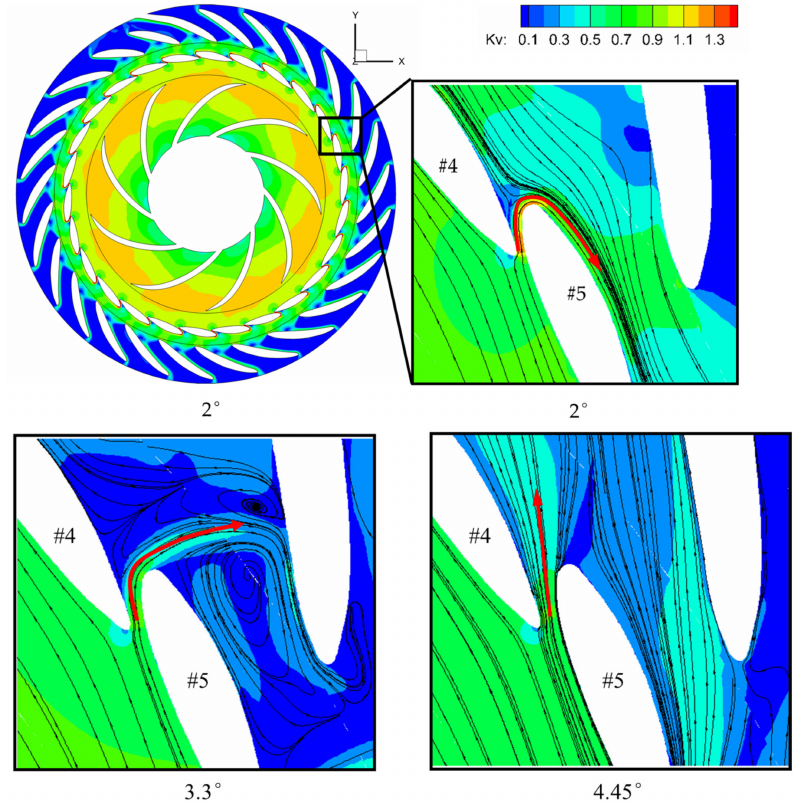
Figure 8. Global velocity contours of the startup process (Z = 0